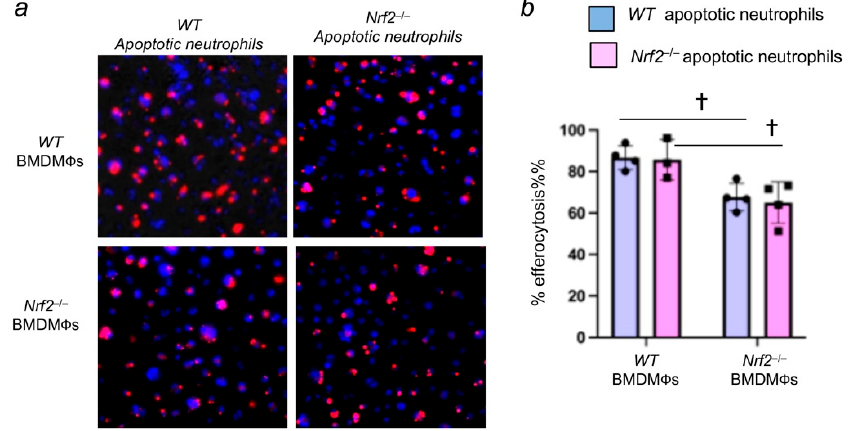
Figure 3. Nrf2-deficiency in neutrophils does not affect their engulfment by macrophages. Neutrophils from the bone marrow of wild-type (WT) and Nrf2 − / − mice were isolated, labelled, and subjected to apoptosis as detailed in methods. Apoptotic neutrophils (red) were incubated with WT BMDM φ s and Nrf2 − / − BMDM φ s for 1 h, and efferocytosis was quantified. ( a ) Representative images of macrophages with apoptotic neutrophils (red). The blue color represents DAPI. ( b ) quantification of efferocytosis. Values are from 3–4 fields of two independent samples. † p < 0.05; Nrf2 − / − versus WT counterparts. Blue, room air group; pink hyperoxia group.